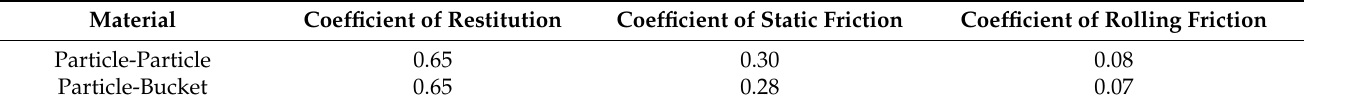
Table 3. Contact parameters of materials.